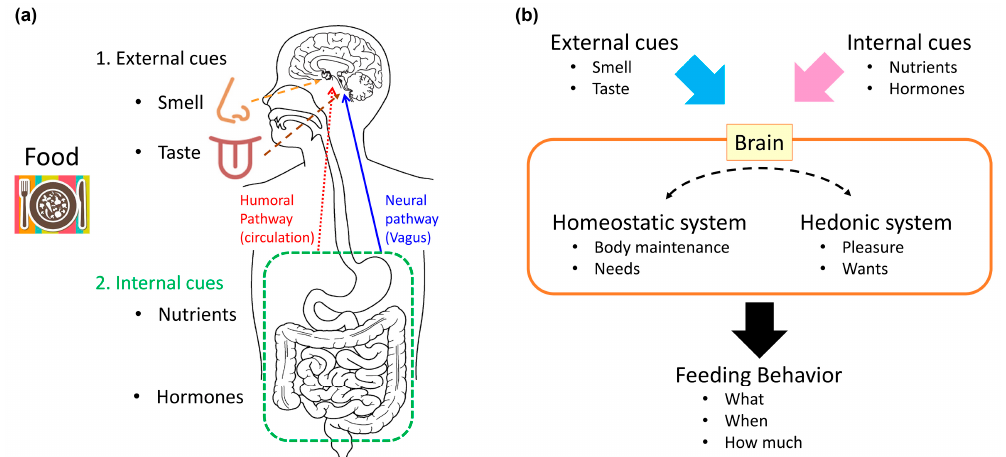
Figure 1. Basic concepts in feeding regulation: ( a ) The types of informational cues conveyed to the central nervous system; ( b ) Two systems in the brain integrate information to regulate feeding behavior.